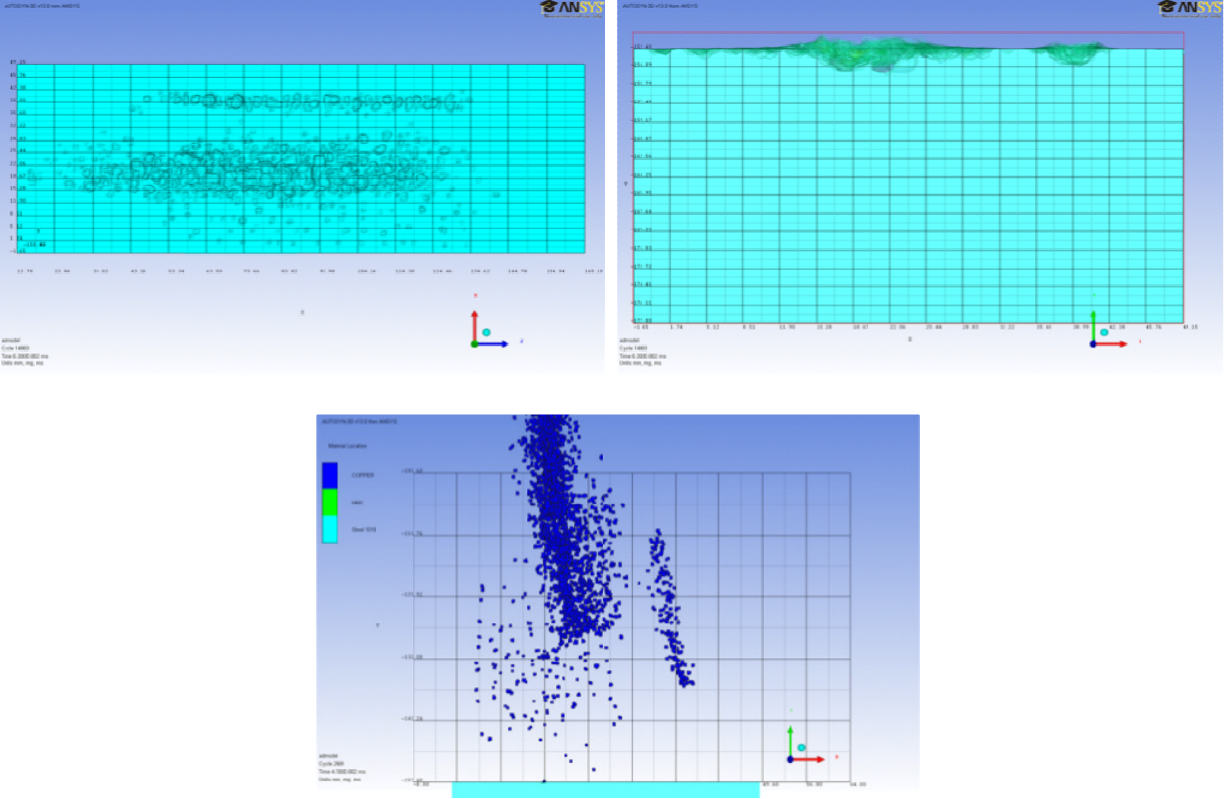
Figure 14. The penetration profile can be seen on the top of the target and in a cross section of the target at a 6 inches (15.24 cm) standoff distance after 15 µs (top left and top right pictures respectively). The bottom picture above shows the jet spreading due to the distance traveled by the